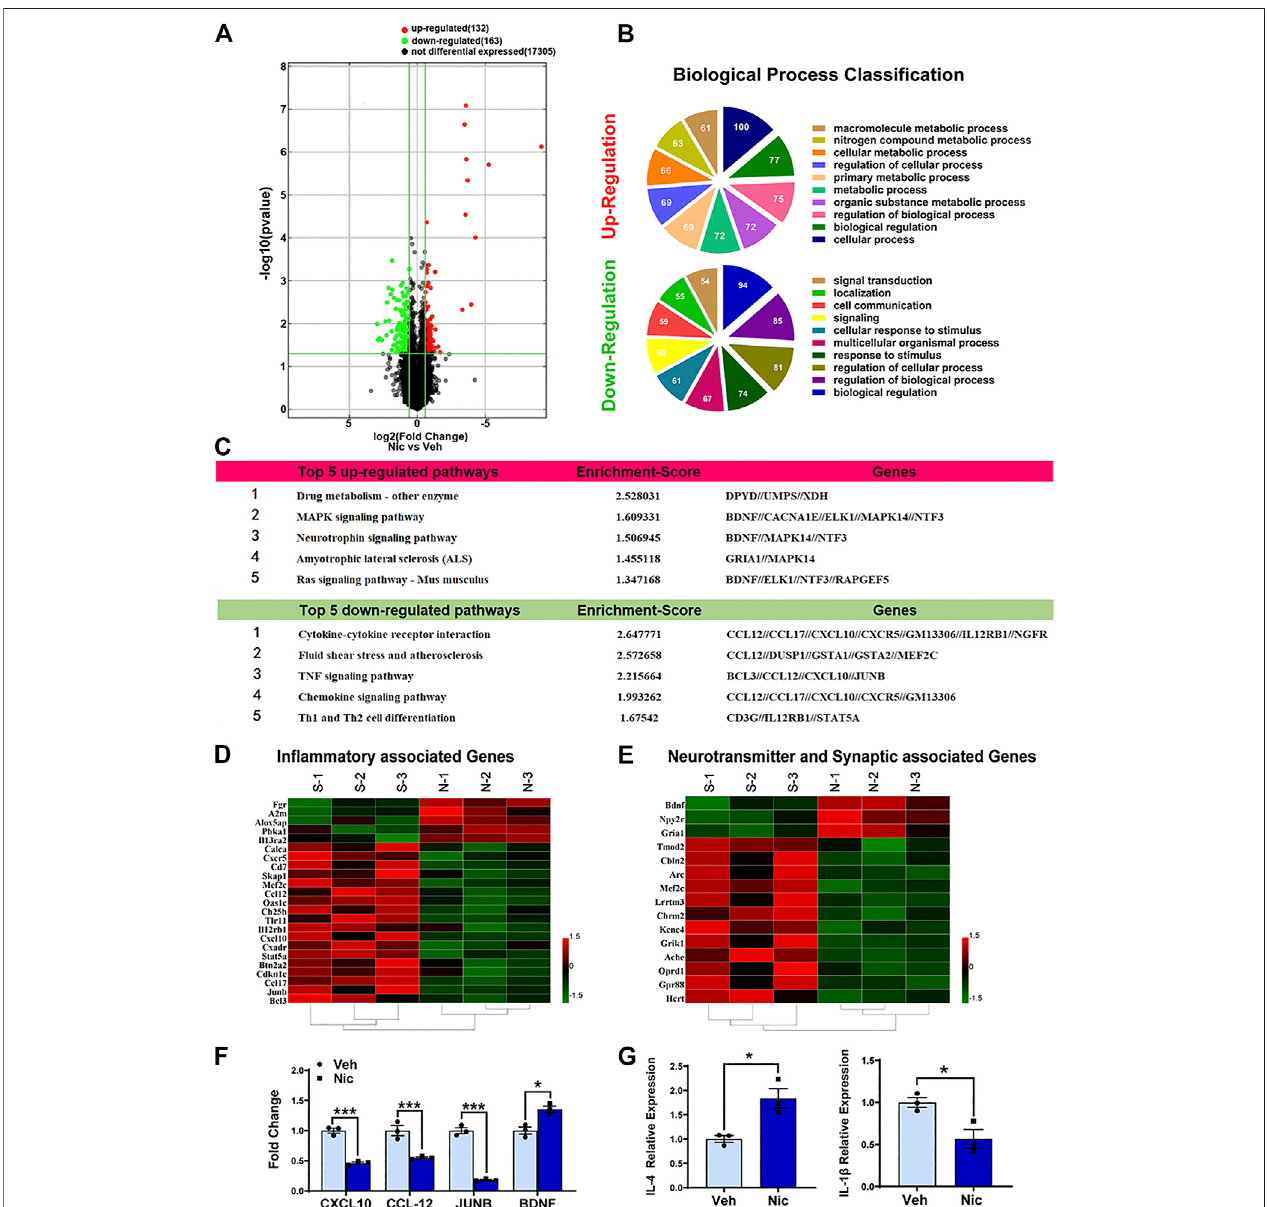
FIGURE3|Bioinformaticanalysisoftheexpressionpro fi lesin20 dayoldoffspring ’ hippocampus.(A) ThedistributionofmRNApro fi leswasillustratedbyvolcano plots. There are 295 differentially expressed genes. “ Red ” indicates high relative expression, and “ green ” indicates low relative expression. (B) The pie chart showed the top 10 signi fi cantenrichmenttermsrepresentedbythebiologicalprocess.Largersectorsrepresentmoresigni fi cantenrichment.Varietiesofbiologicalfunctionswereexpresseddifferently aftermaternalnicotineexposureinthehippocampusofthePND20mice, ascompared tothevehiclecontrol. (C) Thetop fi veupregulatedanddownregulated pathwaysin which hippocampus differentially expressed genes involved were listed. Hierarchical clustering heatmaps of in fl ammatory genes (D) , neurotransmitter, and synaptic associated genes (E) were generated using HEML software. (F) Con fi rmation of the microarray results, the expression of TNF and neurotrophin signaling pathway-related genes were validated by quantitative real-time PCR. (G) The representative genes of different in fl ammatory responses, IL-4 and IL-1 β , were detected by quantitative real-time PCR. The columns represent the log-transformed median fold changes in expression relative to the vehicle group. * p < 0.05, all data are means ± SEM.